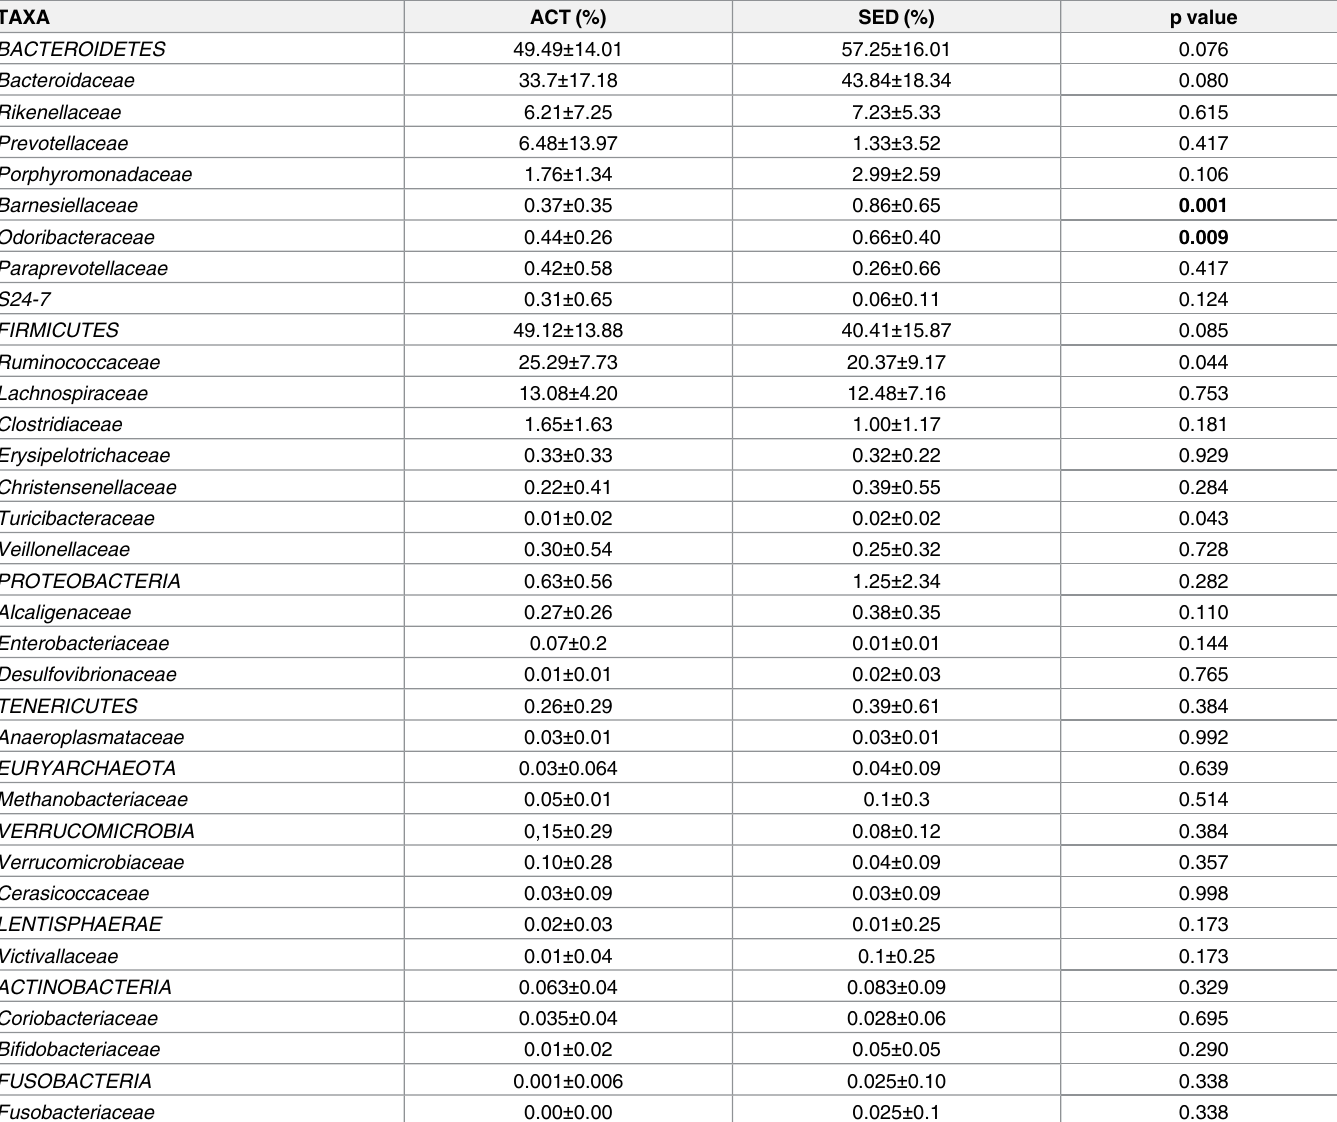
Table 3. Bacterial phyla and families in feces of active and